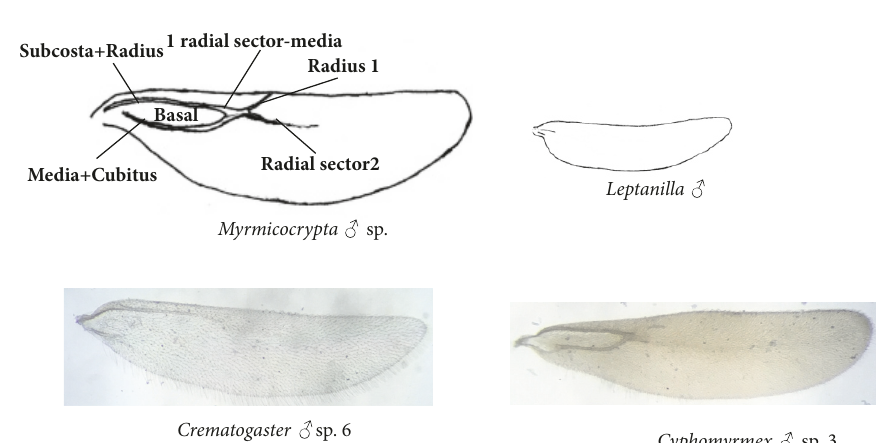
Figure 3: Hindwing of Typology III with Cells and Veins terminology. The photos represent some examples of hindwings of Typology III; the dimensions are not comparable (photos by personal Cantone collection of Winged